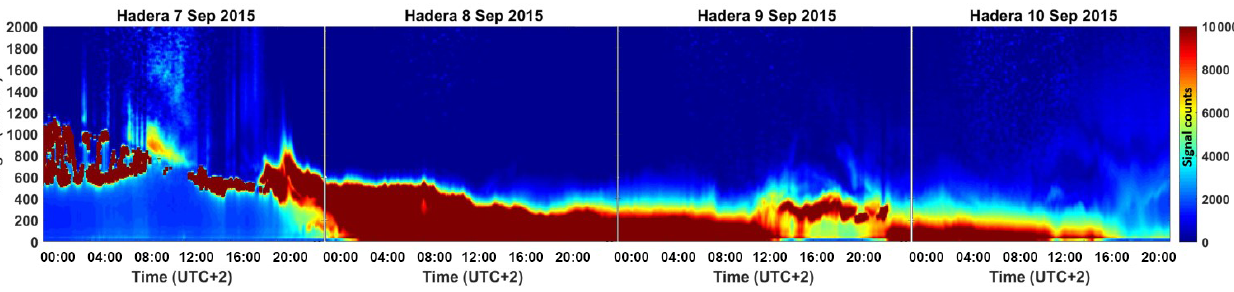
Figure 7. Hadera ceilometer signal counts plots for 7–10 September 2015. The y axis is the height from site deployment to 2000ma.s.l., the x axis is the time in LST (UTC + 2), and the signal count scale ranges between 0 and